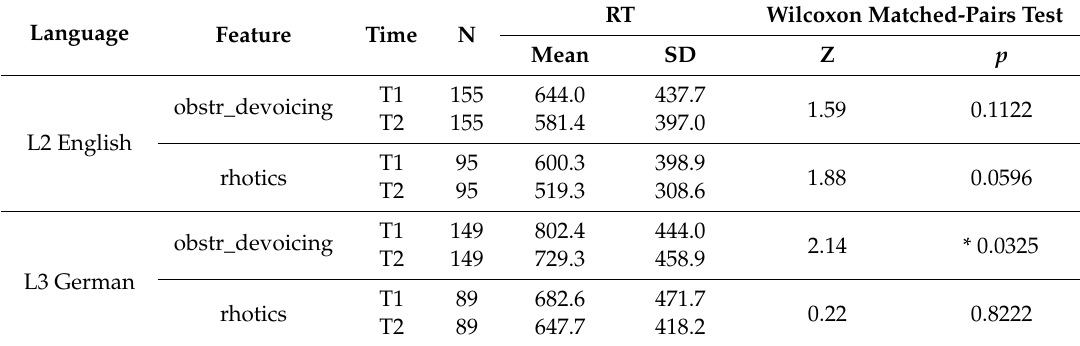
Table 4. Reaction time (RT) for L2 / L3 at T1 and